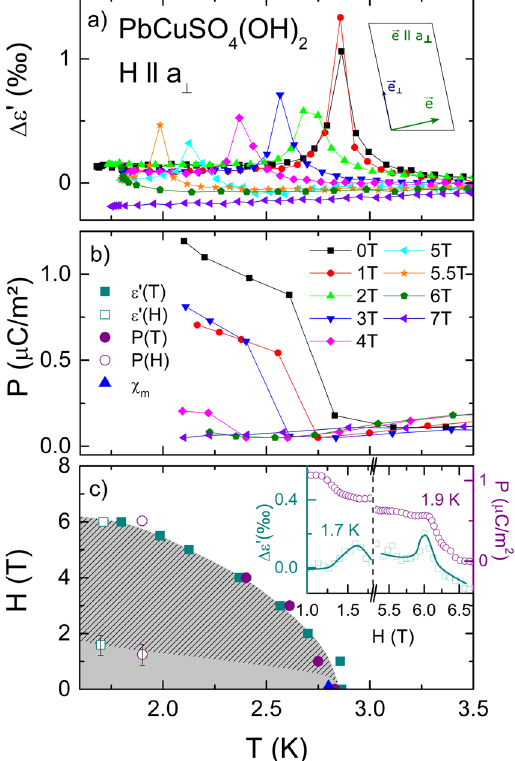
Figure 3. Dielectric properties at 300 Hz with E || a of a PbCuSO 4 (OH) 2 single crystal with magnetic field along the a ⊥ direction. ( a ) Temperature dependent dielectric constant for various magnetic fields. The dielectric constant is normalized to a constant value and deviations are shown in parts per thousand (‰). The inset illustrates the spin configuration between H 1 and H 2 . ( b ) Temperature dependent electrical polarization performed for different magnetic fields, with a poling field E pol = 2 kV/cm. ( c ) ( T , H ) phase diagram constructed using results from the present work; the grey shaded area indicates the rotated spin spiral state. The inset shows magnetic field dependent dielectric constants and polarization at 1.7 and 1.9 K, respectively (lines are drawn to guide the